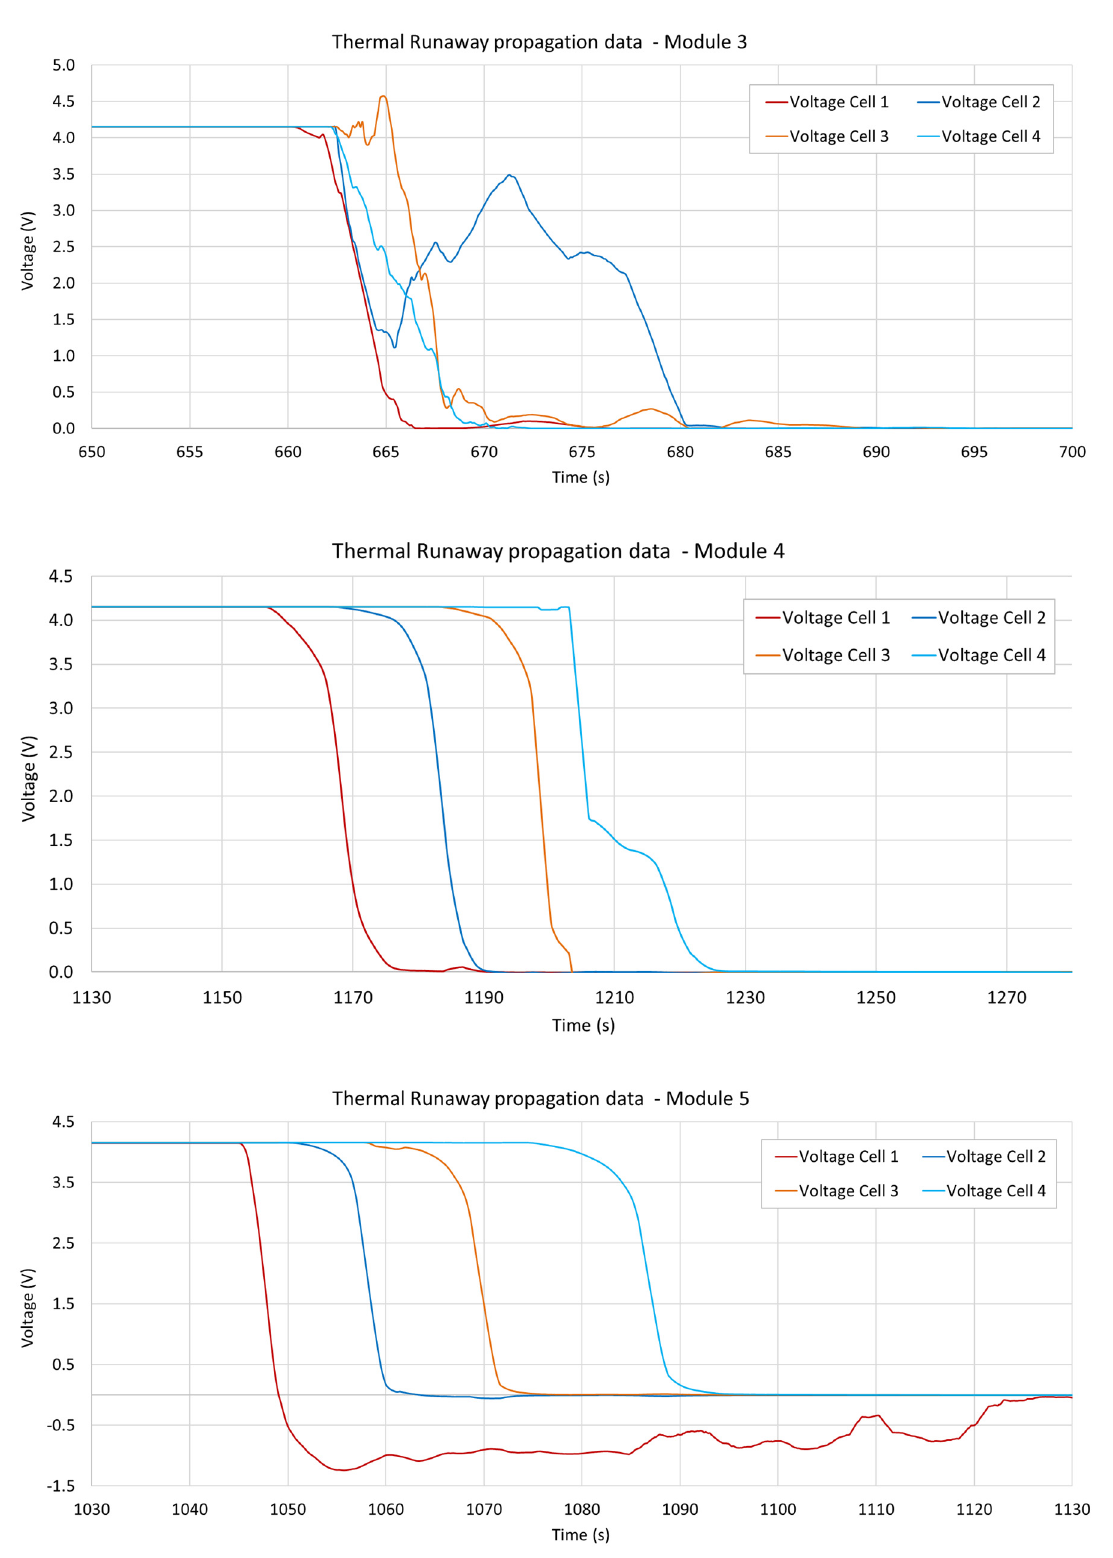
Figure A2. Voltage measurements of modules 1,3,4,5.